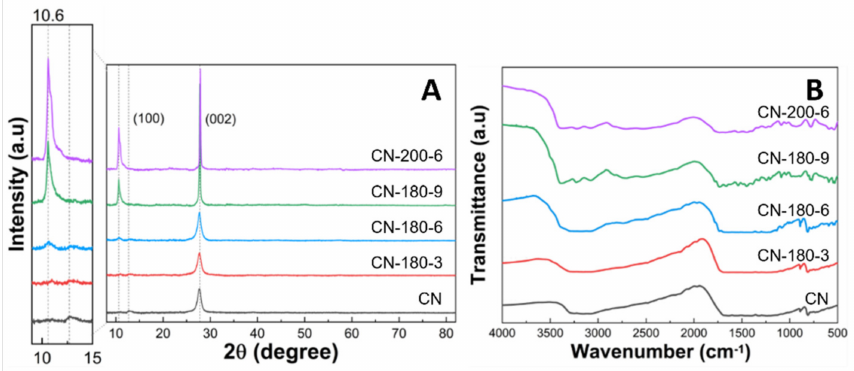
Figure 3. ( A ) XRD patterns and ( B ) FT-IR spectra of CN-180-x and CN-200-6